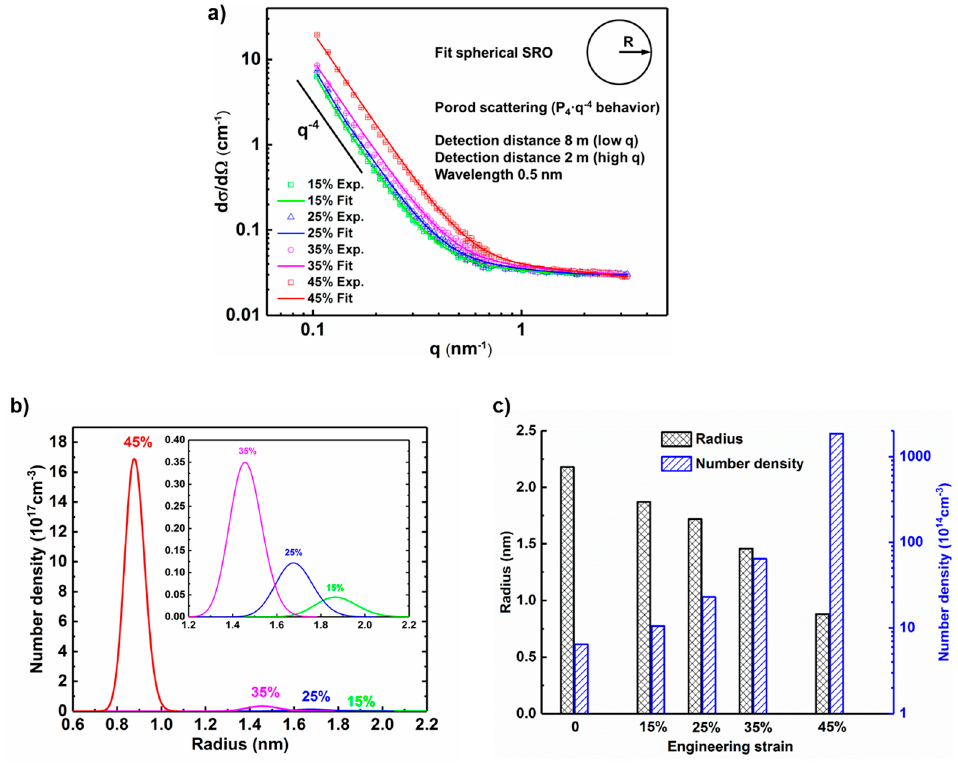
Figure 5. ( a ) SANS scattering curves; ( b ) number density-size distribution and ( c ) mean radius and number density of Mn-C SRO in deformed samples at strains of 15–45%.